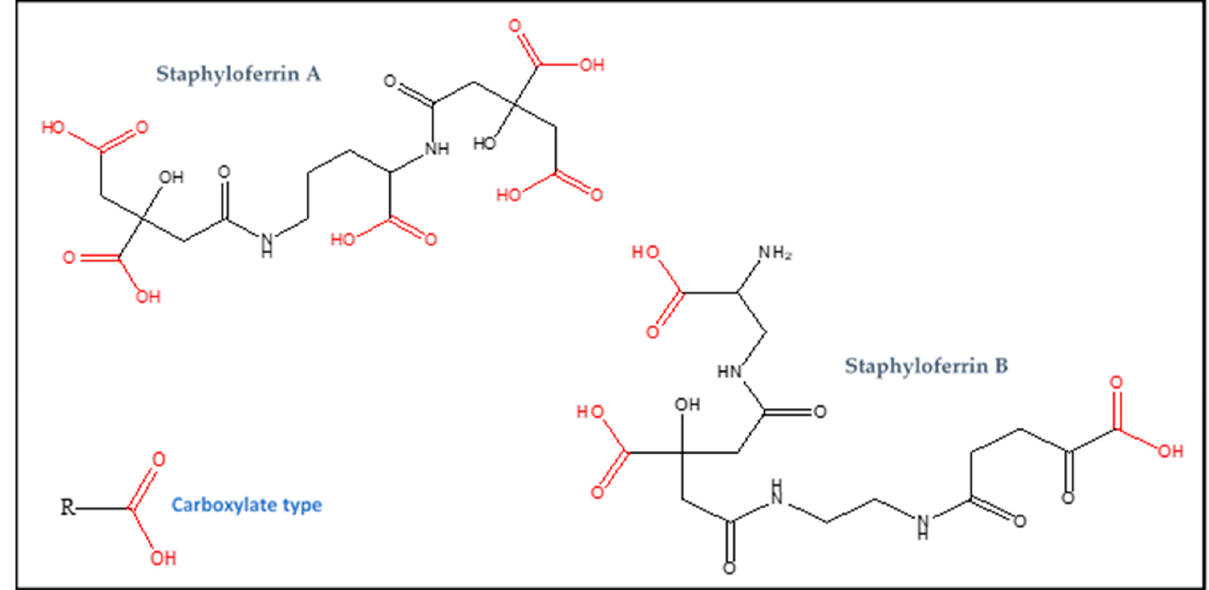
Figure 1. The structure of the two siderophores: Staphyloferrin A and B .